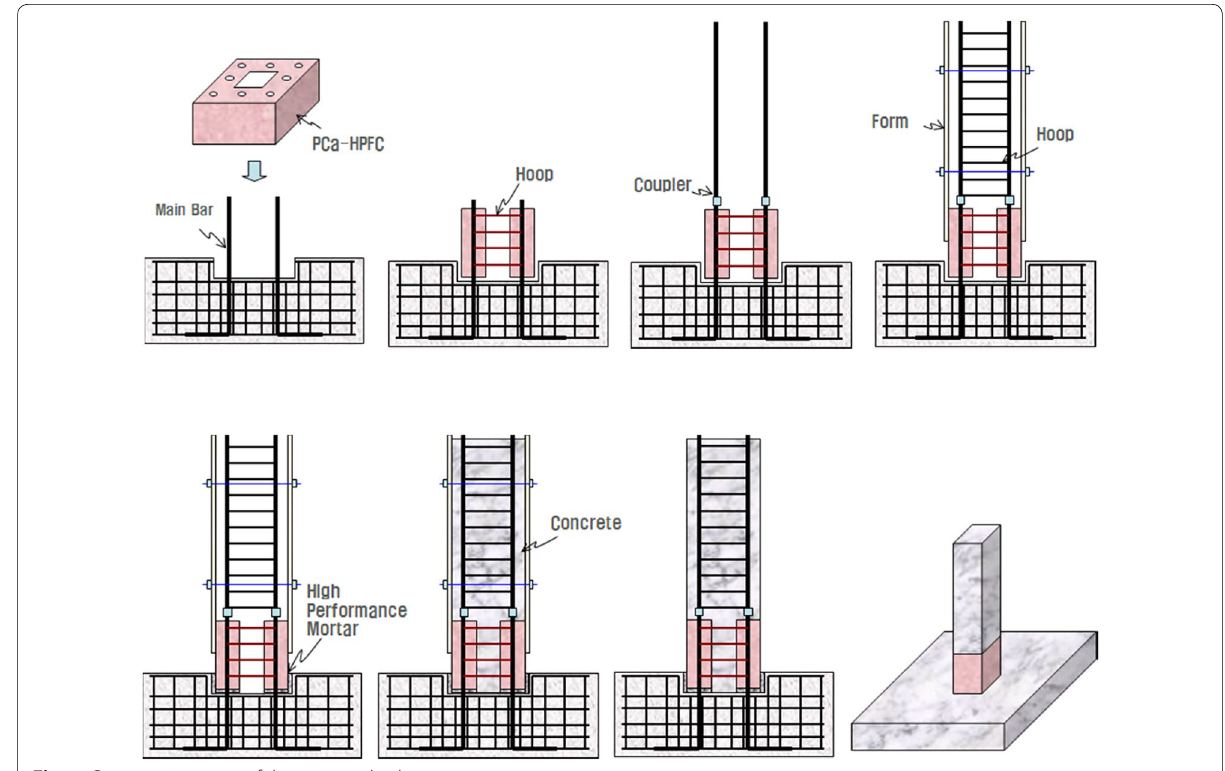
Fig. 5 Construction stage of the proposed column.